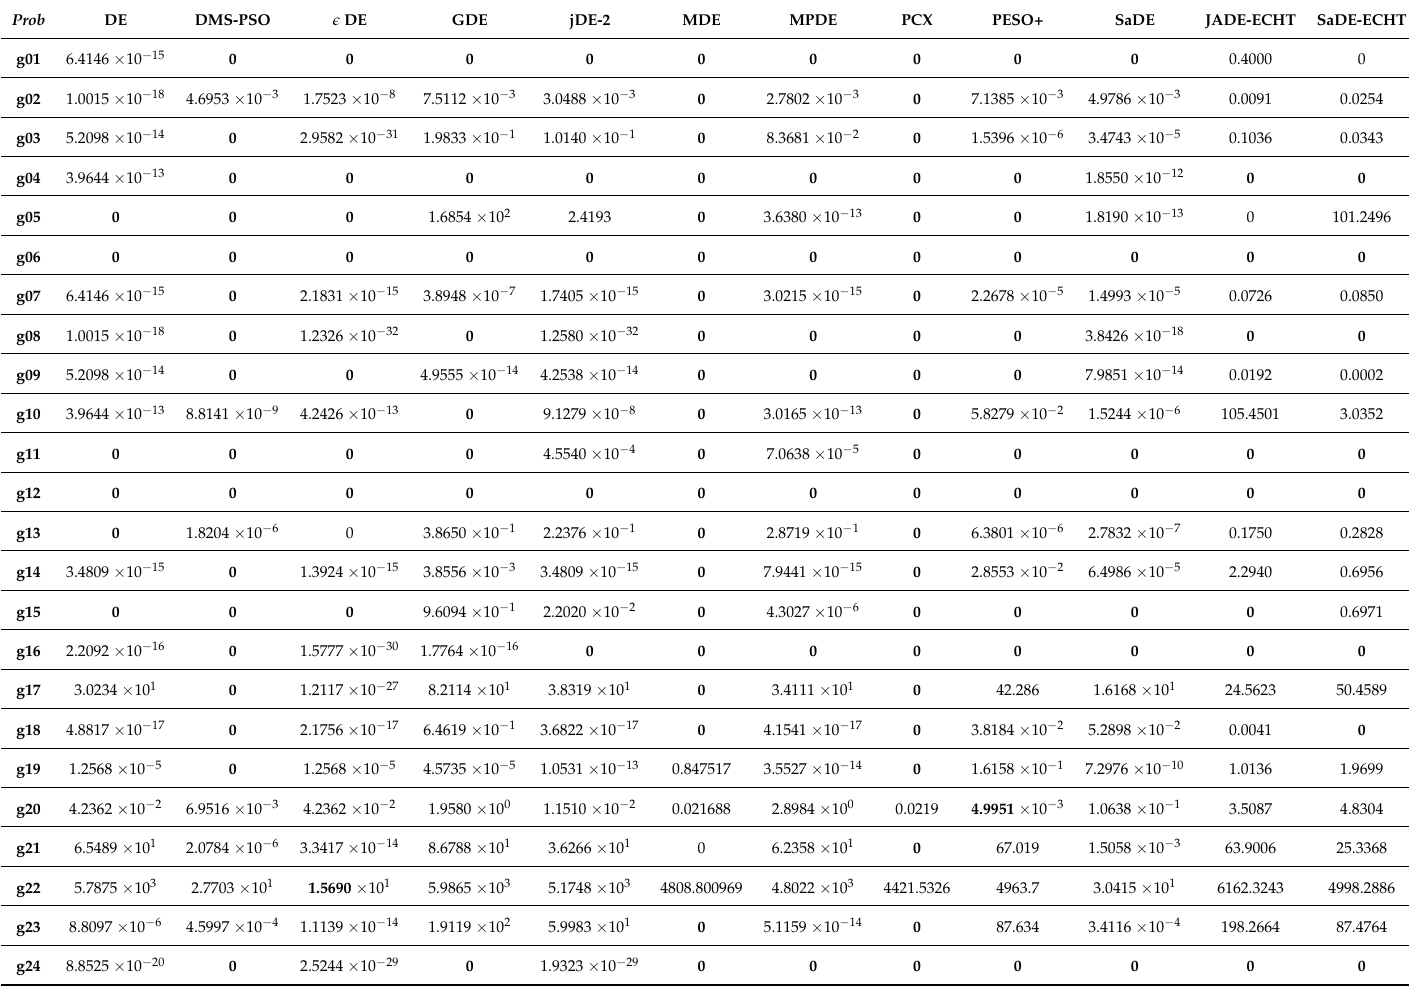
Table 9. Comparison of standard deviation values of JADE-ECHT, SaDE-ECHT and CEC’2006 algorithms achieved after 500,000 FEs. The bold numbers indicate the better